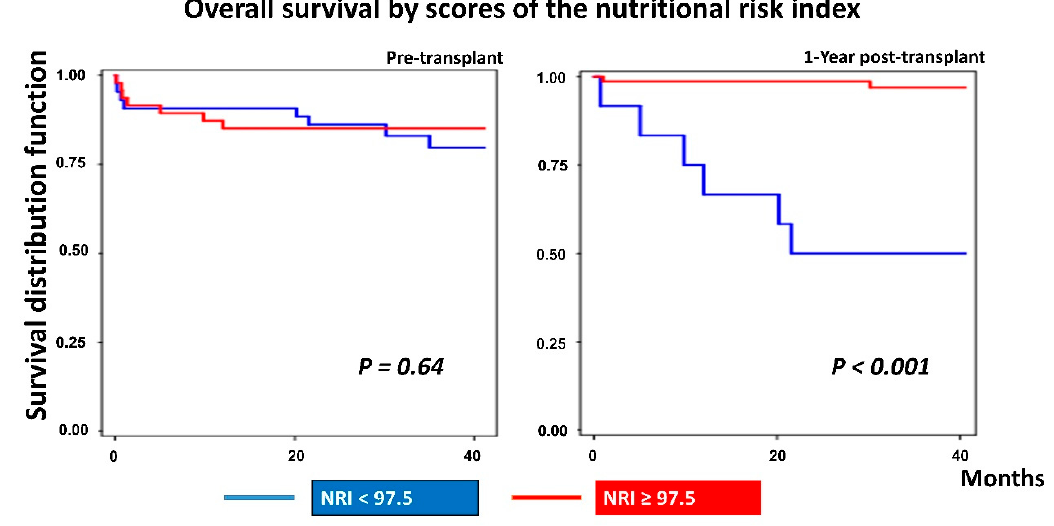
Figure 4. Kaplan–Meier plot of overall survival by NRI.